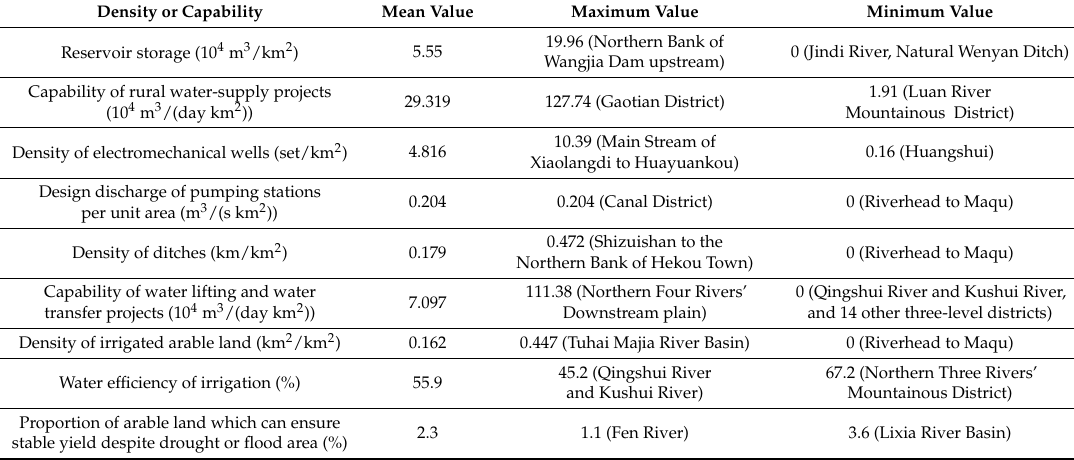
Table 3. Density or capability of water conservancy projects in the Huang-Huai-Hai River